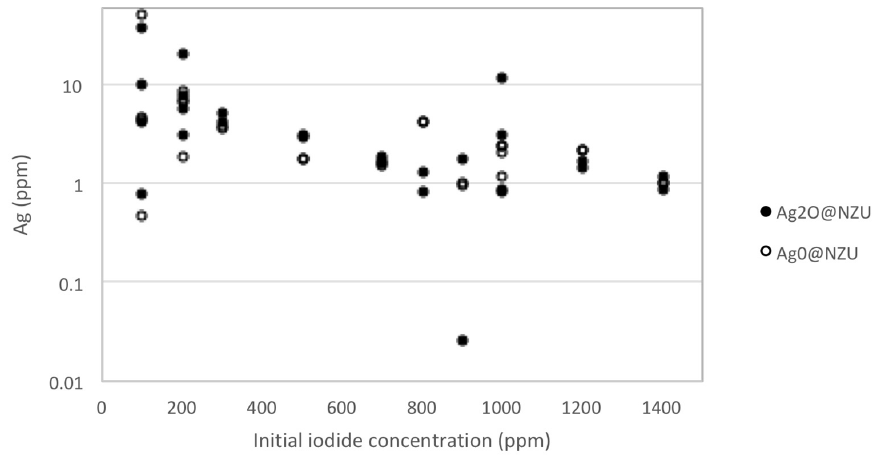
Figure 12. Ag leaching results (52 experiments).